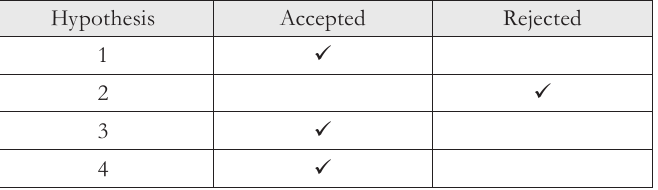
Tab. 6 - Summary of Hypotheses testing. Source: constructed by the